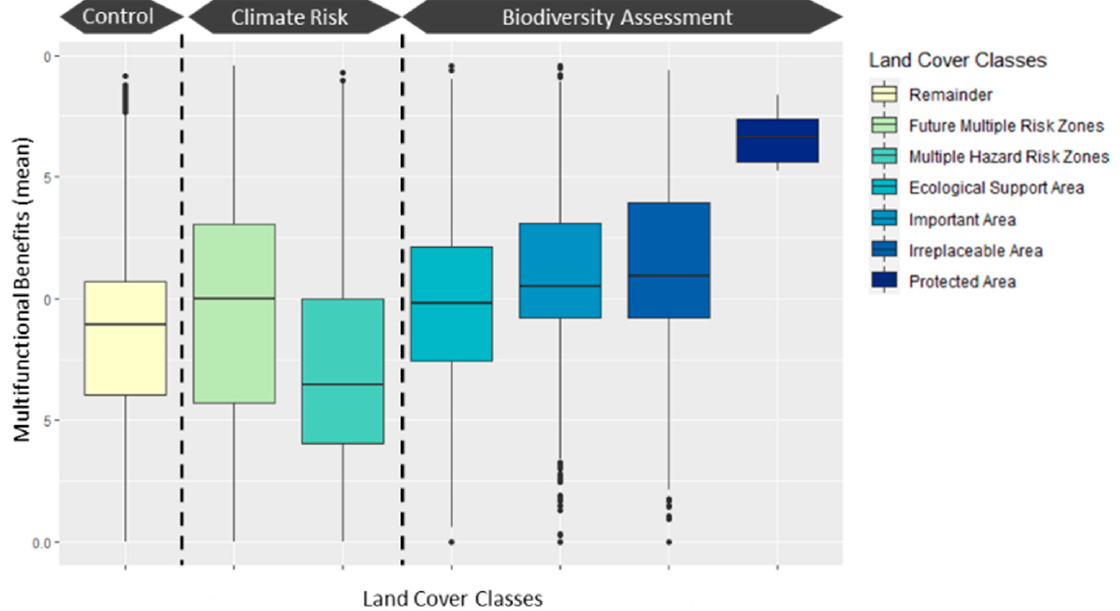
Figure 5. Differences between the means and spread of the measured green infrastructure benefit in the City of Tshwane, summarized by the land cover classes categorized in existing decision tools: Gauteng Biodiversity and Conservation Plan (C-Plan), and Climate Risk and Vulnerability Assessment (CRVA), which prioritize biodiversity protection and climate resilience, respectively.